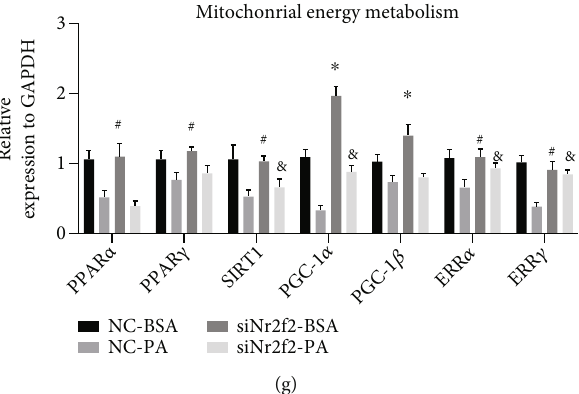
Figure 3: Knockdown of Nr2f2 alleviated ferroptosis induced by palmitic acid in neonatal rat cardiomyocytes. (a) Representative Western blot of PTGS2 and GPX4 ( n = 4 , means ± SDs , ∗ p < 0 : 05 and ∗∗ p < 0 : 01 ; ns: not signi fi cant, two-way ANOVA). (b) MDA level in each group ( n = 6 , means ± SDs , ∗∗∗ p < 0 : 005 ; ns: not signi fi cant, two-way ANOVA). (c) Lipid ROS was assessed by C11 BODIPY 581/591 staining coupled with fl ow cytometry analysis ( n = 3 , means ± SDs , ∗ p < 0 : 05 and ∗∗∗ p < 0 : 005 ; ns: not signi fi cant, two-way ANOVA). (d) Cell viability was measured by CCK8 ( n = 6 , means ± SDs , ∗∗∗ p < 0 : 005 , two-way ANOVA). (e) Mitochondrial membrane potential was measured by JC-1 staining; red fl uorescence represents healthy mitochondria, while green indicates loss of mitochondrial potential (scale bar = 50 μ m , n = 6 , means ± SDs , ∗∗∗ p < 0 : 005 , two-way ANOVA). (f) Intracellular ATP level in each group ( n = 6 , means ± SDs , ∗ p < 0 : 05 , ∗∗ p < 0 : 01 , and ∗∗∗ p < 0 : 005 ; ns: not signi fi cant, two-way ANOVA). (g) Relative expression of mitochondrial energy metabolic genes ( n = 6 , means ± SDs , NC-BSA vs. siNr2f2-BSA, # p > 0 : 05 and ∗ p < 0 : 05 ; NC-PA vs. siNr2f2-PA, & p < 0 : 05 , two-way HNE protein level decreased GSH the content ( 10 : 200 ± 1 : 476 vs. 4 : 633 ± 1 : 104 nmol/mg wet tissue) and SOD activ- ity ( 18 : 930 ± 1 : 453 vs. 14 : 950 ± 0 : 982 units/mg wet tissue)